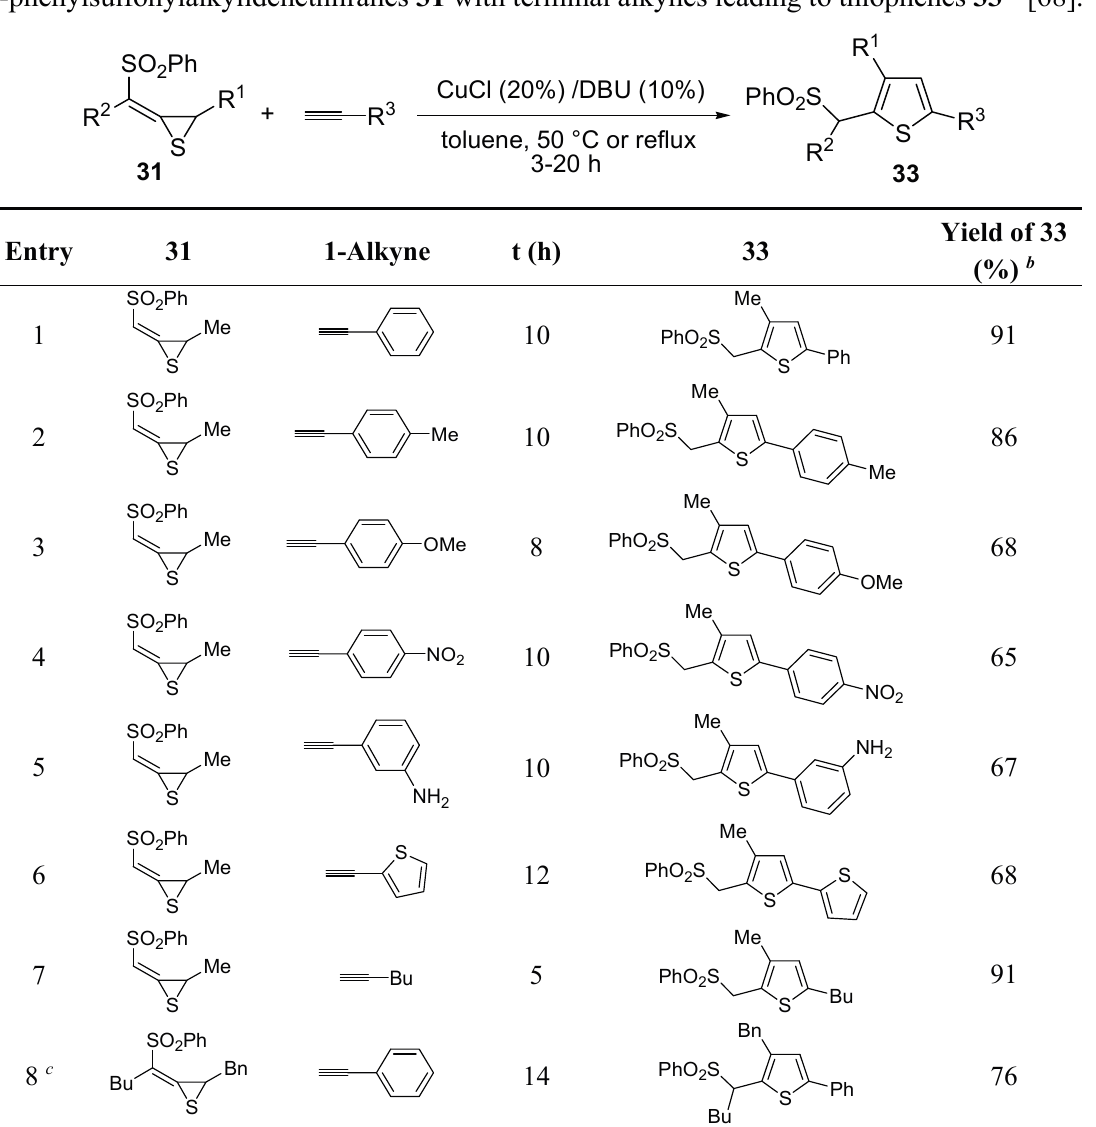
4. CuCl/DBU-catalyzed tandem addition/cycloisomerization